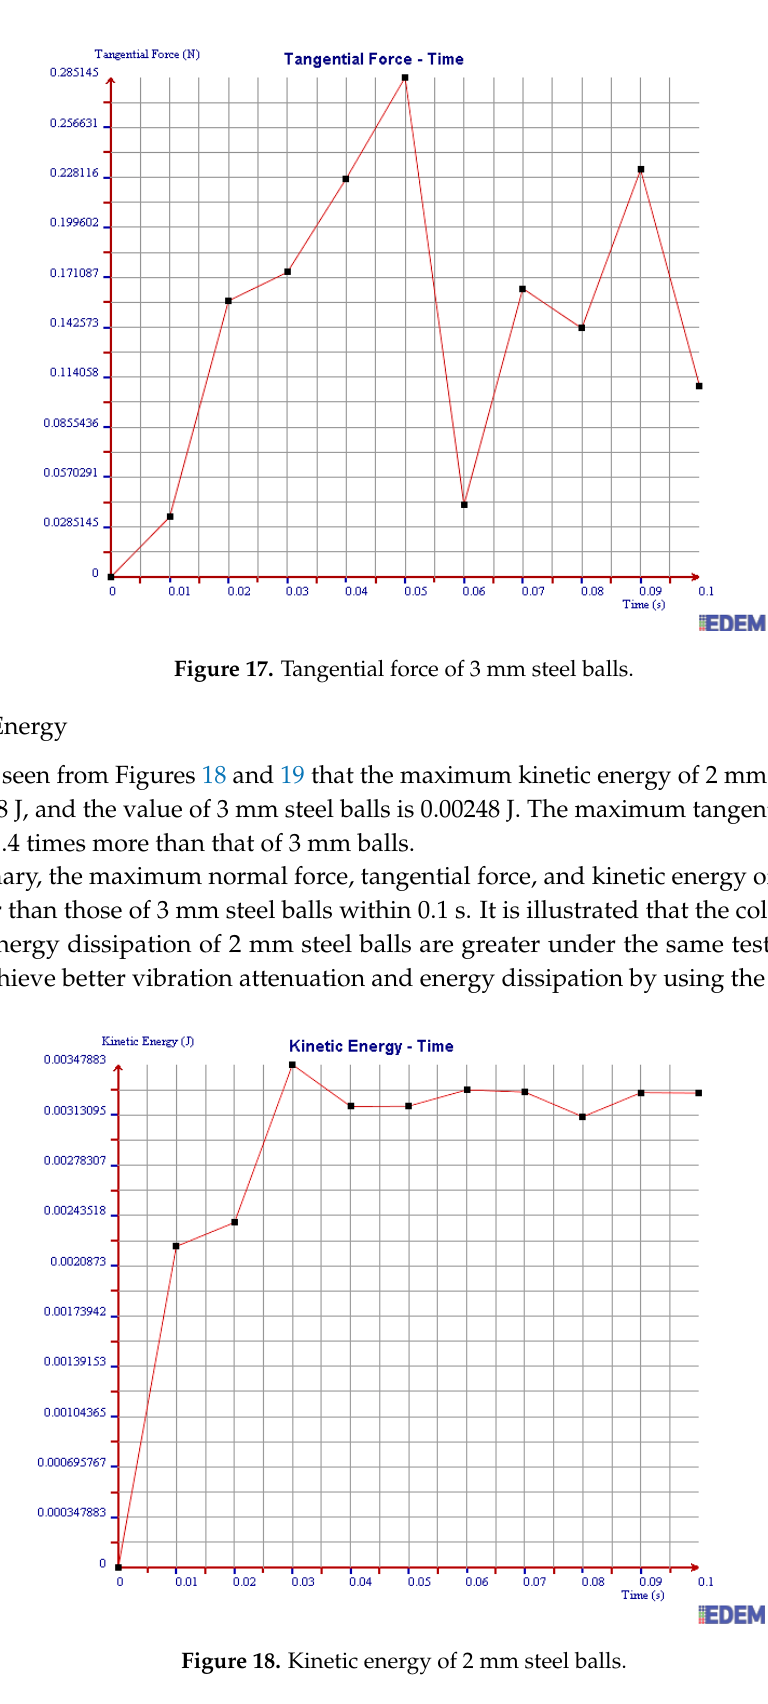
Figure. 19 Kinetic energy of 3 mm steel balls. 4.2.2. Influence of Particle Materials on Damping Effect In this section, the normal force, tangential force, and kinetic energy of chromium balls with a diameter of 2 mm are simulated, respectively. As can be seen in Figures 20–22, the maximum values of normal force, tangential force, and kinetic energy of 2 mm chromium balls within 0.1 s are 1.82 N, 0.17 N, and 0.00225 J respectively, which are smaller than those of 3mm steel balls. Additionally, the maximum values of normal force, tangential force, and kinetic energy of 2 mm steel balls within 0.1 s are 3 times, 3.94 times, and 1.55 times more than those of 2 mm chromium balls, respectively. Through comparing the maximum normal force, tangential force, and kinetic energy within 0.1 s of 2 mm steel balls, 3 mm steel balls, and 2 mm chromium balls, the values of 2 mm steel balls are the